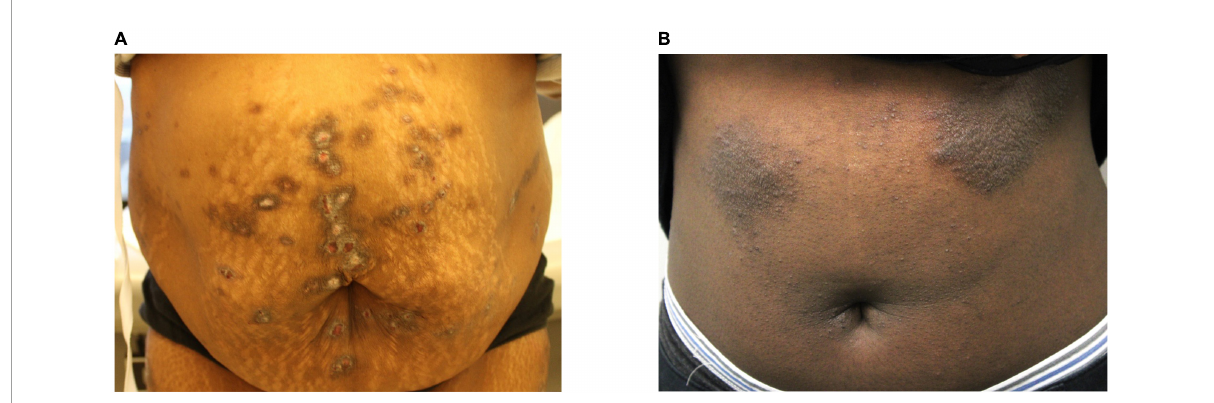
FIGURE1 Clinical images of prurigo nodularis and atopic dermatitis lesions. (A) Prurigo nodularis patient with fibrotic and hyperkeratotic lesions on the abdomen. (B) Atopic dermatitis patient with lichenified lesions on the